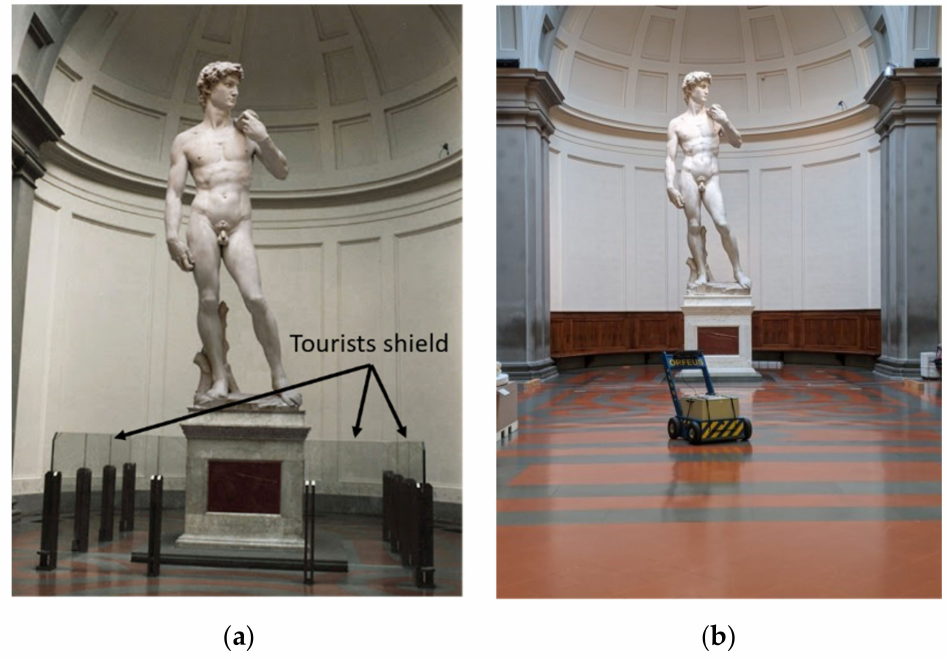
Figure 1. Michelangelo’s David: ( a ) the Michelangelo’s David and the apse of the “Tribuna” with shatterproof glass installed as a shield for tourists; ( b ) the statue in January 2021 without